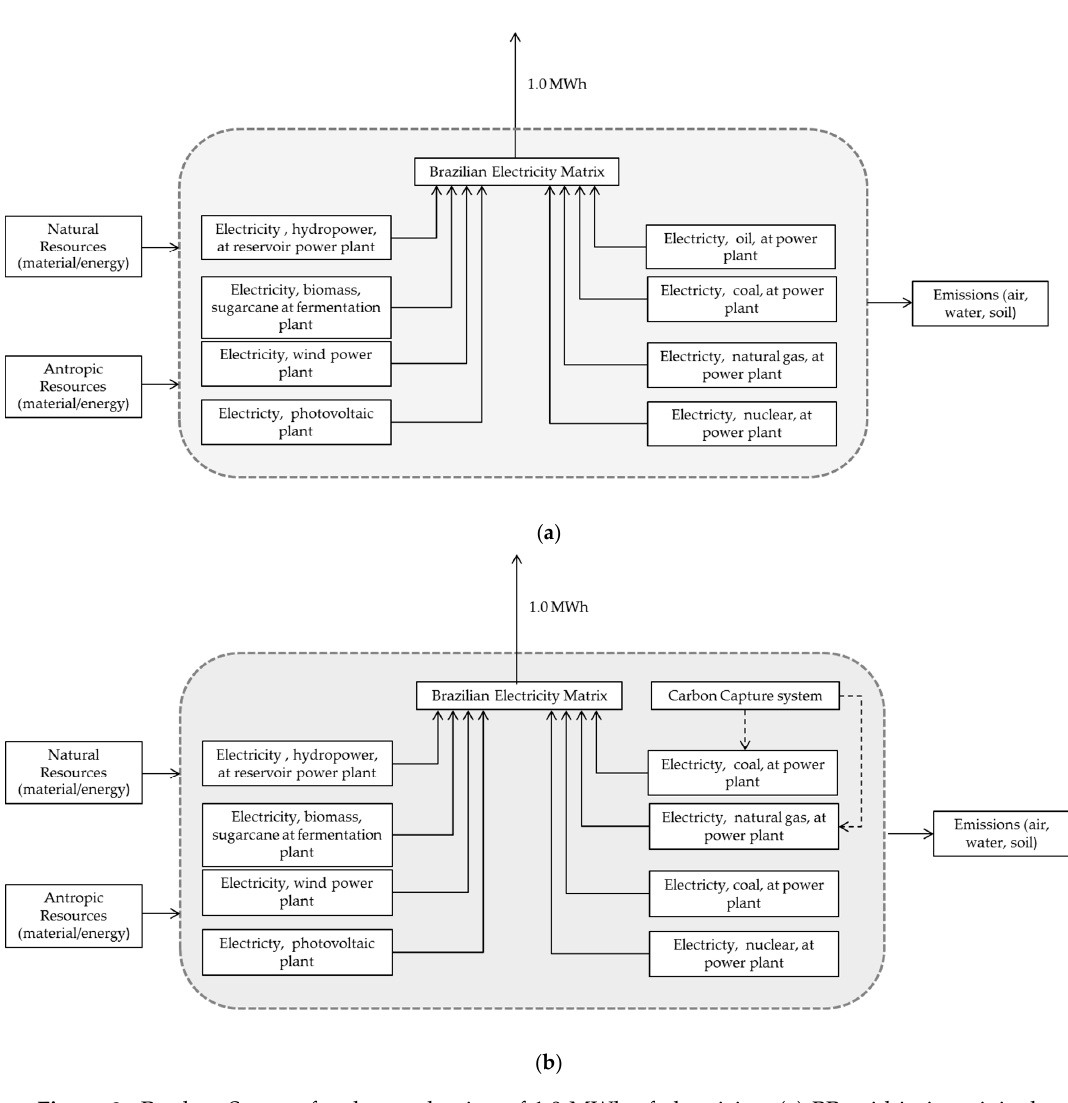
Figure 3. Product System for the production of 1.0 MWh of electricity: ( a ) BR grid in its original structure, and; ( b ) coupled to CCS.